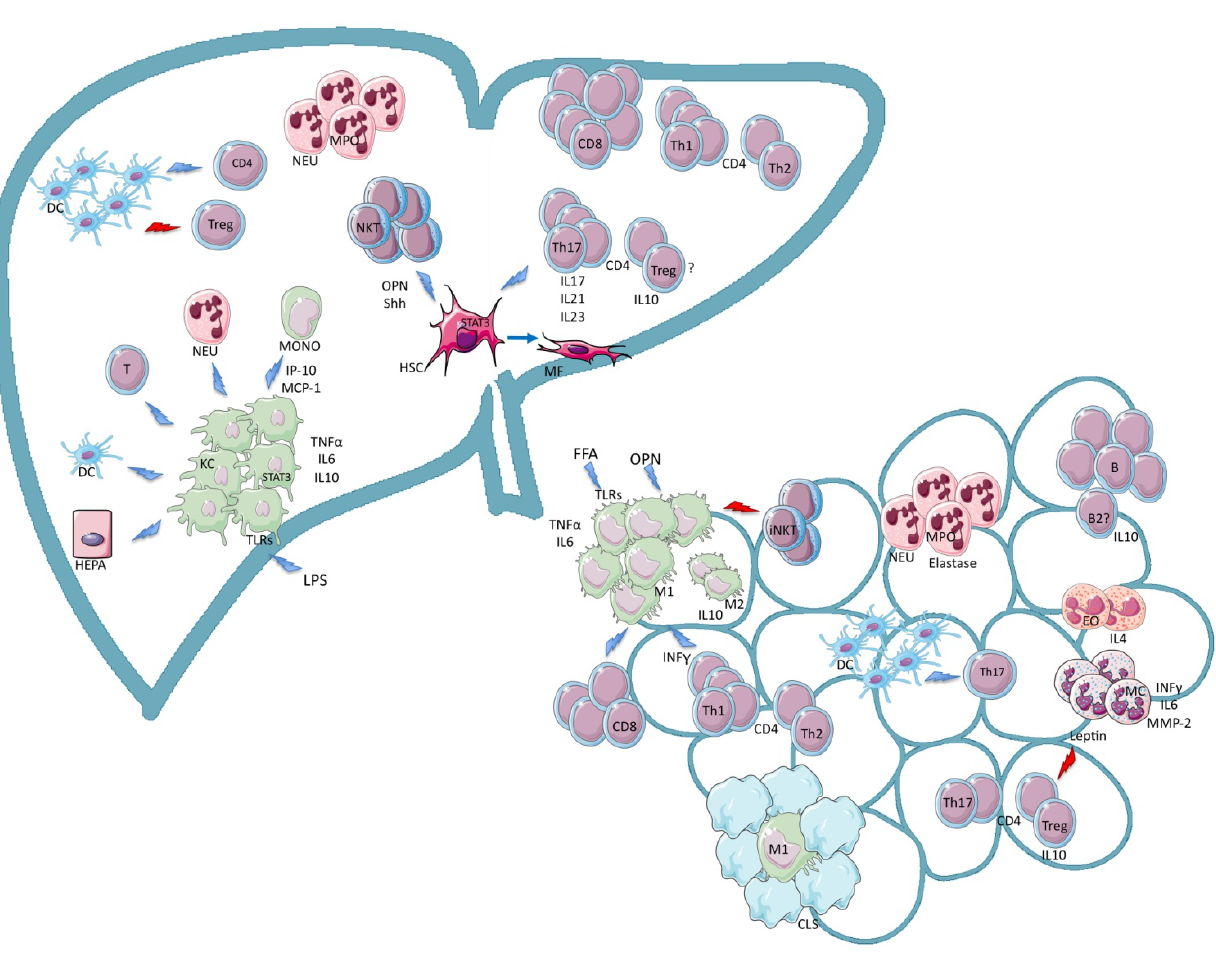
Figure 1. Overview of the immune pathways implicated in the pathogenesis of non-alcoholic steatohepatitis (NASH). DC: dendritic cells; Treg: T regulatory cell;